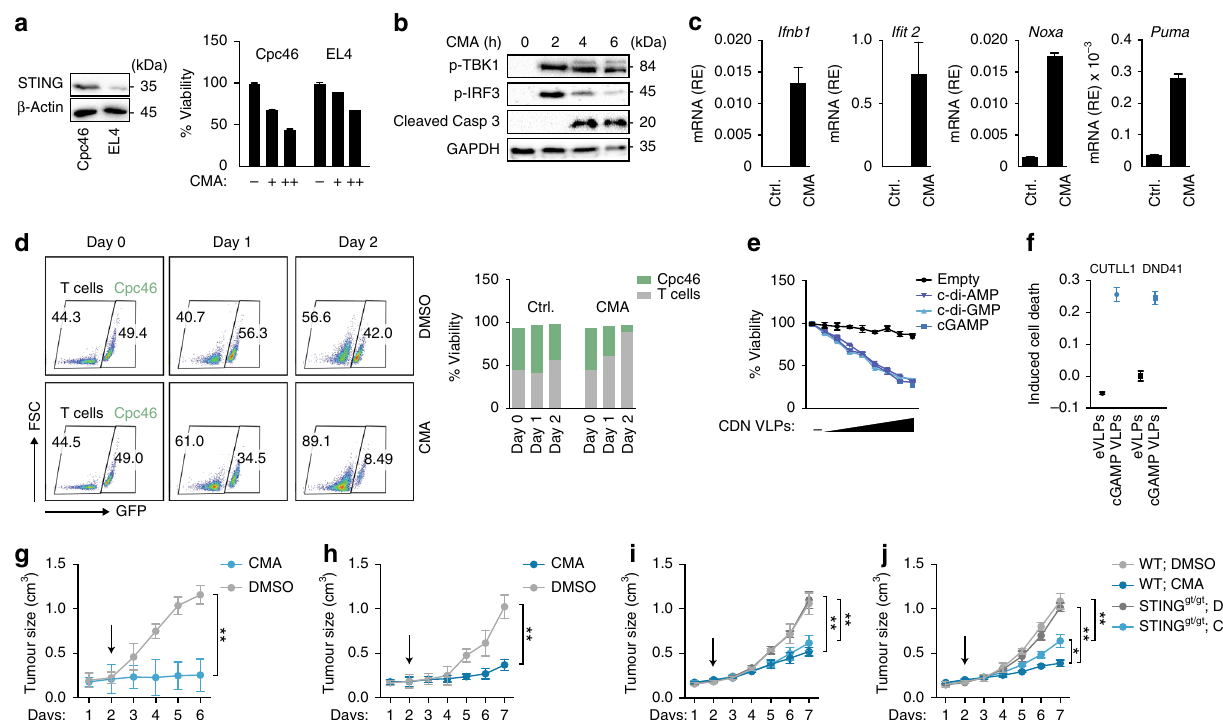
Fig. 6 Pharmacological hyperactivation of STING promotes apoptosis of T-cell-derived malignant cells. a Murine T-ALL cells (Cpc46) and lymphoma cells (EL4) were incubated with 10-carboxymethyl-9-acridanone (CMA) for 16 h and cell viability was assessed by CellTiter Blue assay. b Cpc46 cells were treated with DMSO (upper panel) or CMA (lower panel) and phosphorylation of TBK1, IRF-3 and cleavage of caspase-3 was assessed at indicated times by immunoblot. c Cpc46 cells were treated with DMSO or CMA and the induction of indicated genes was quanti fi ed by RT-qPCR after 4 h. d Primary CD4 + T cells (in the presence of CD3 and CD28 activation) and Cpc46 cells ( x axis, GFP + cells) were cultured in a 1:1 ratio and treated with DMSO (upper panel) or CMA (lower panel). After 1 day and 2 days percentages of GFP + cells (Cpc46 cells) vs. GFP − primary T cells were determined by FACS. e Cpc46 cells were incubated with empty viral particles (eVLPs) or VLPs containing cGAMP (cGAMP VLPs), c-di-AMP or c-di-GMP for 16 h and cell viability was assessed by CellTiter Blue assay. f CUTLL1 cells and DND41 cells were left untreated or incubated with eVLPs or cGAMP VLPs and percentages of apoptotic cells were measured by FACS after 16 h. g – j Subcutaneous in vivo growth of Cpc46 cells ( g ) and EL4 cells ( h ) in Rag2 − / − γ c − / − mice or Cpc46 cells ( i ) and EL4 cells ( j ) in wild-type (WT) or STING gt/gt mice that were treated with or without (Ctrl.; treatment with diluent only) CMA (500 µ g), daily after tumour size reached up to 200 mm 3 . (Cpc46, n = 3 mice per treatment group; EL4, n = 5 mice per treatment group). Tumour size was measured daily. Arrow indicates starting point of the treatment. Data are representative of n = 3 ( a ; left) or n = 2 ( b ) independent experiments or mean and s.d. of one representative experiment out of n = 3 ( a , c – f ) or mean and s.d of n = 3 (Cpc46 cells) or n = 5 (EL4 cells) mice per treatment group are shown g – j . ** P < 0.01 (two-way ANOVA). Unprocessed original blots are shown in Supplementary Fig.